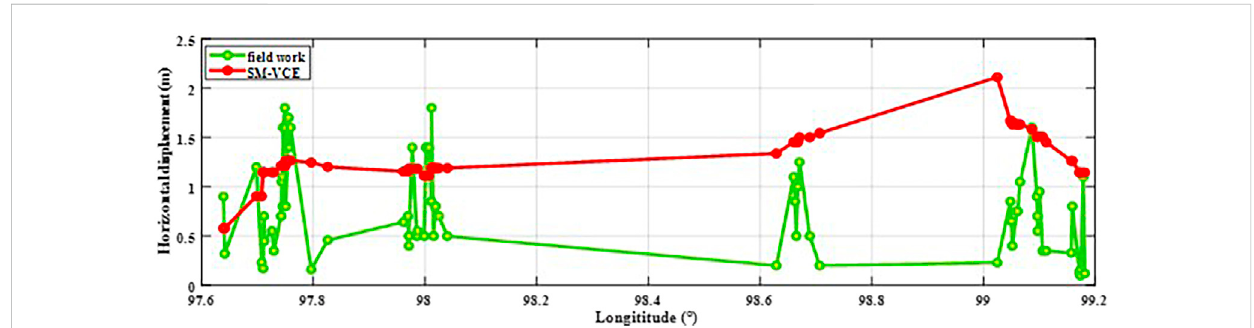
FIGURE 8 Comparison between the horizontal displacements based on SM-VCE method and in fi eld